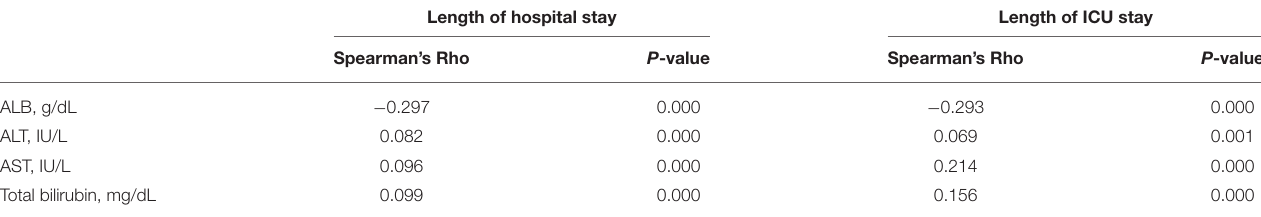
TABLE 2 | The correlation of blood albumin (ALB), alanine transaminase (ALT), aspartate transaminase (AST), and total bilirubin with hospital stay and ICU stay. Length of hospital stay Length of ICU stay